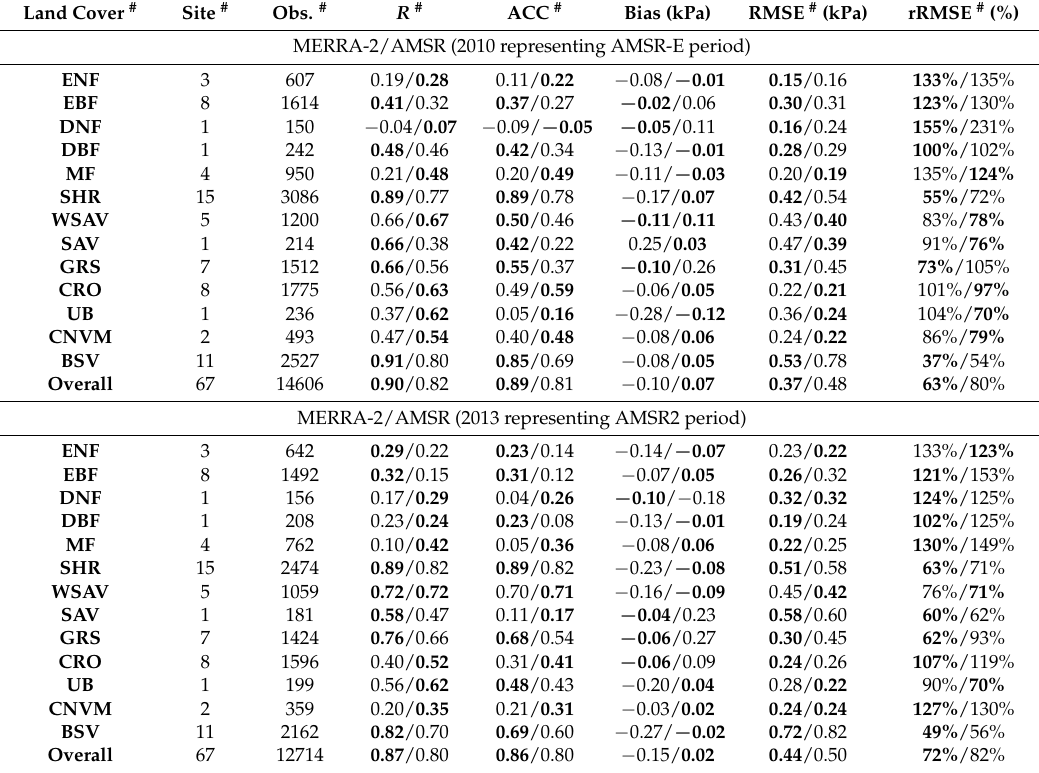
Table 2. Summary of the accuracy of daily morning (~1:30 a.m.) Vapor Pressure Deficit (VPD) levels derived from respective the Modern-Era Retrospective analysis for Research and Applications, Version 2 (MERRA-2) and the Advanced Microwave Scanning Radiometer (AMSR) Land Parameter Data Record (LPDR) datasets for 2010 and 2013 in relation to in situ Integrated Surface Global Hourly (ISH) station measurements from 67 global validation sites. The best performance of each metric is highlighted in